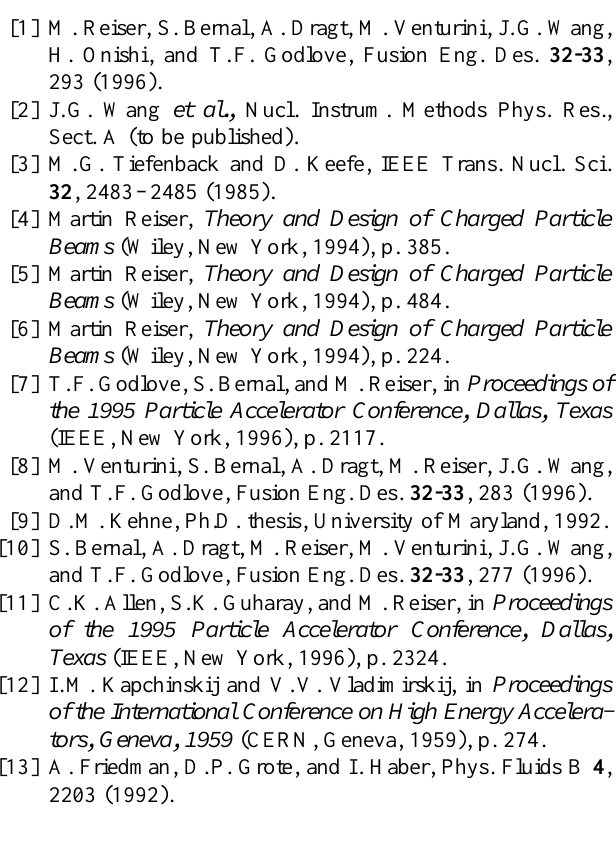
Fig. 5. (Color) Experiment vs calculations. The solid lines are results from the PIC code WARP , while the dashed lines are from the KV code SPOT